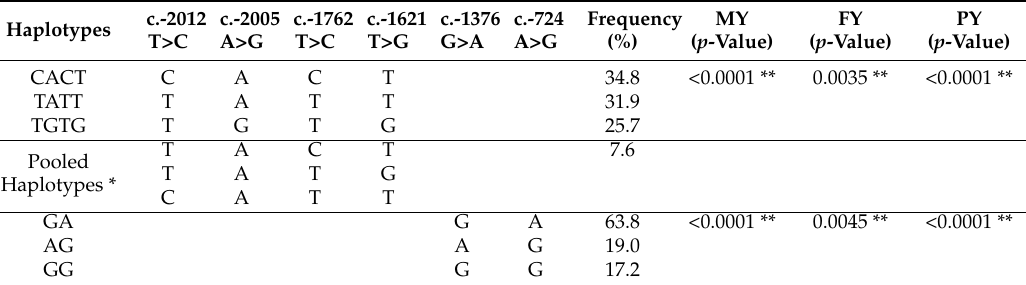
milk production